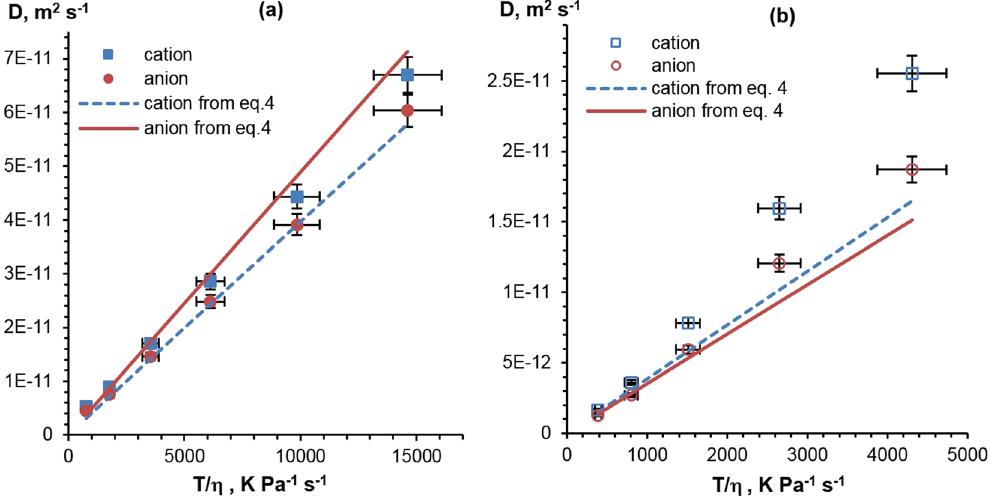
Figure 4. Diffusion coefficients as a function of T/ η for [C 2 MIM][OAc] ( a ) and [C 2 MIM][OOct] ( b ). Lines show linear fits calculated with Eq. 4 and each ion’s radius from Eq.